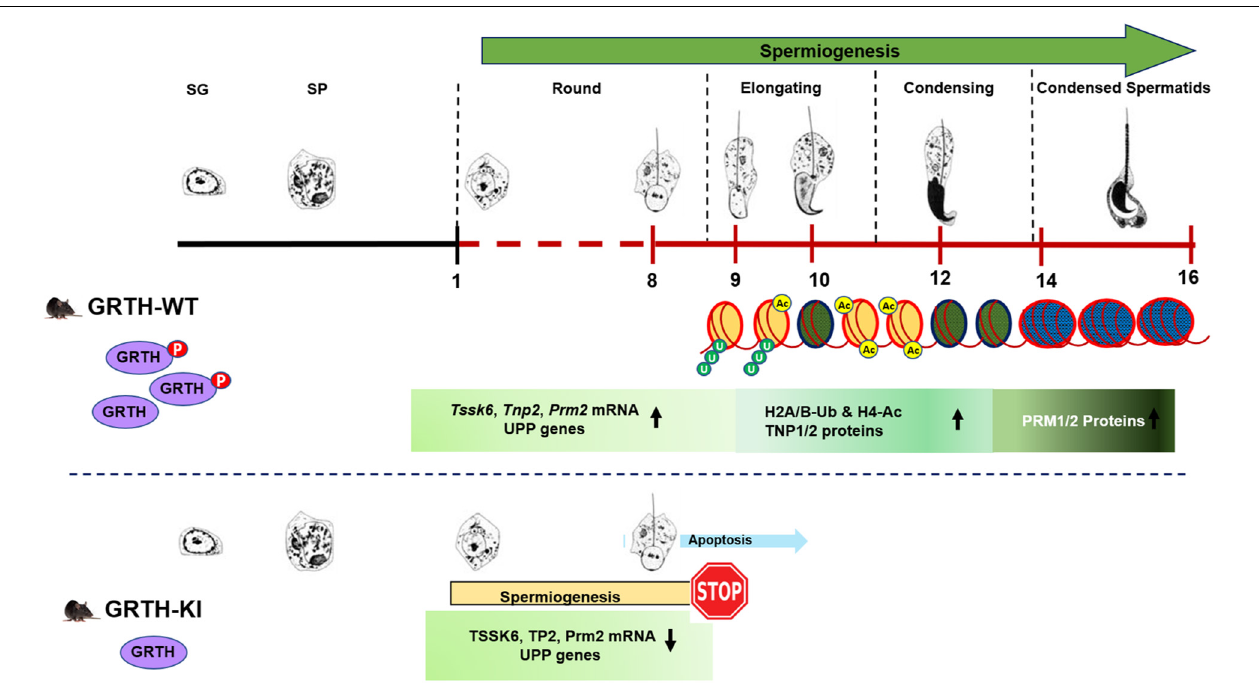
FIGURE 8 | Role of p-GRTH in histone ubiquitination and acetylation essential for round spermatid during spermiogenesis. Schematic diagram showing progression of mice spermiogenesis where germ cells undergo 16 different steps of development. In WT mice during the process of spermiogenesis in RS we observed increased and stable expression of Tssk6, Tnp2, Prm2, and UPP mRNAs until ready for translation in step 9 of RS. During spermatid elongation histones undergo ubiquitination (H2A/B-Ub) and acetylation (H4-Ac) resulting in their removal and replacement with transition proteins and protamines making the chromatin more compact/condensed. Of note is that in KI mice loss of p-GRTH has direct impact on expression of UPP genes required for ubiquitination and subsequent acetylation which impairs round spermatids to elongation.